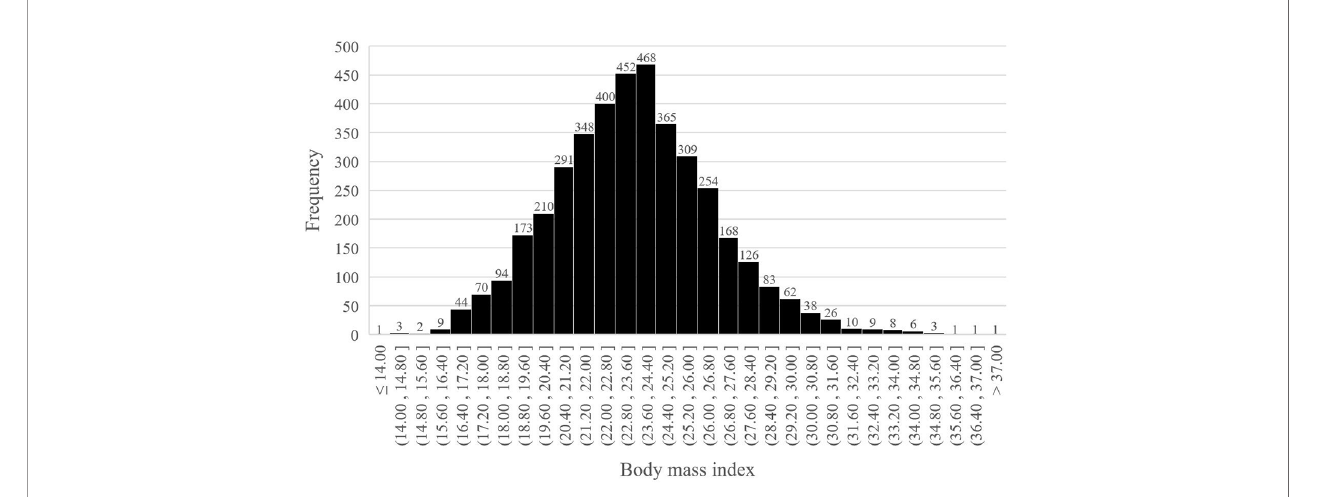
FIGURE 2 | Body mass index distribution.